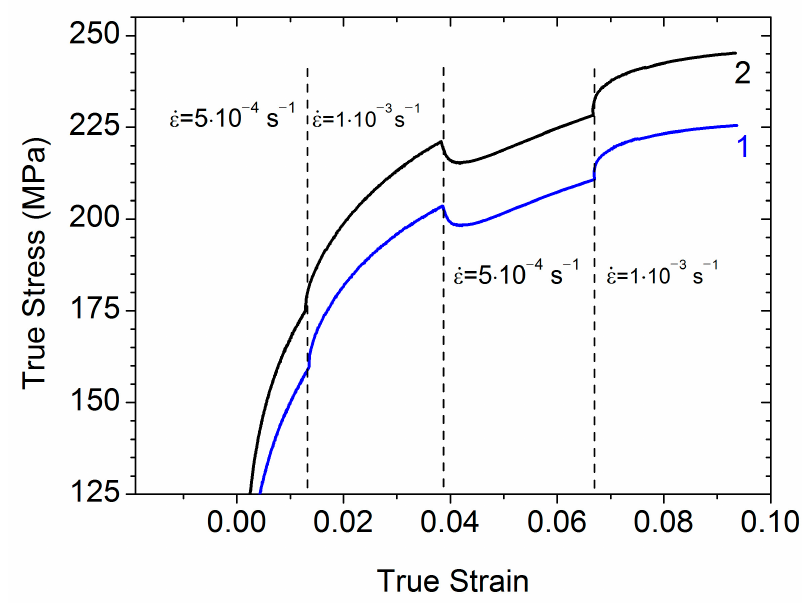
. Figure 7. Strain-rate jump test at the base strain rate of ε = 5 × 10 − 4 s − 1 for Al–0.4Zr alloy samples Figure 7. Strain-rate jump test at the base strain rate of 𝜀(cid:4662) = 5 × 10 − 4 s − 1 for Al–0.4Zr alloy samples in in HPT (curve 1) and HPT + AN + 0.25 HPT (curve 2) HPT (curve 1) and HPT + AN + 0.25 HPT (curve 2) states.